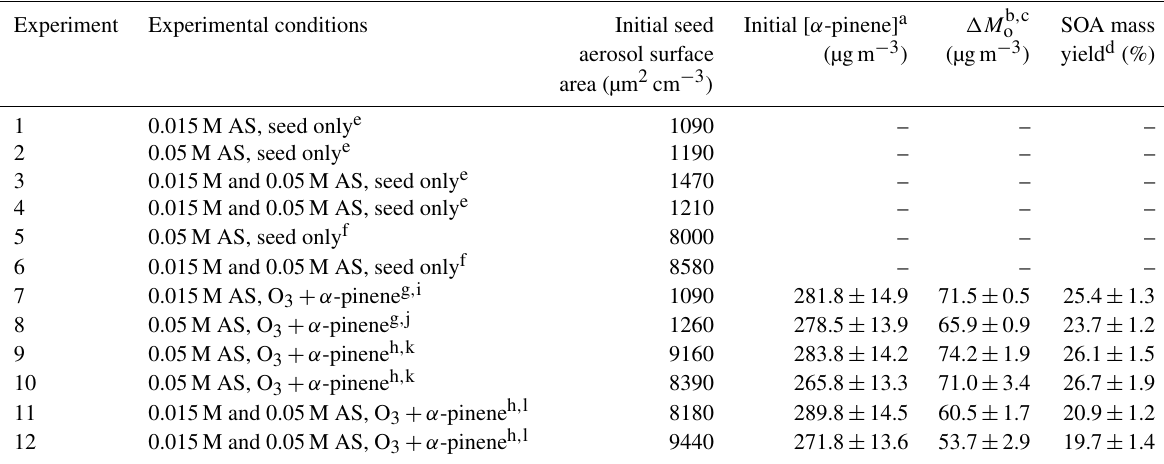
Table 1. Experimental conditions and results.